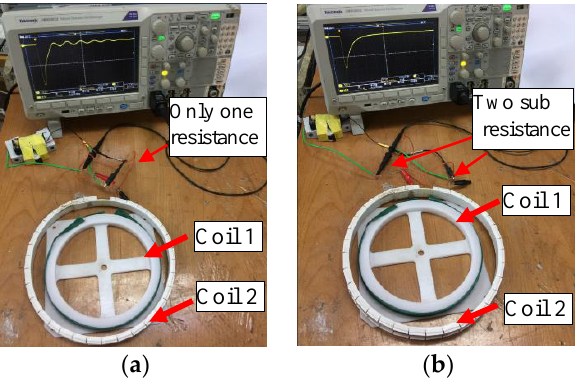
Figure 12. Comparison of two multi-coil systems. ( a ) Single-damped coil system; ( b ) double-damped coil system.